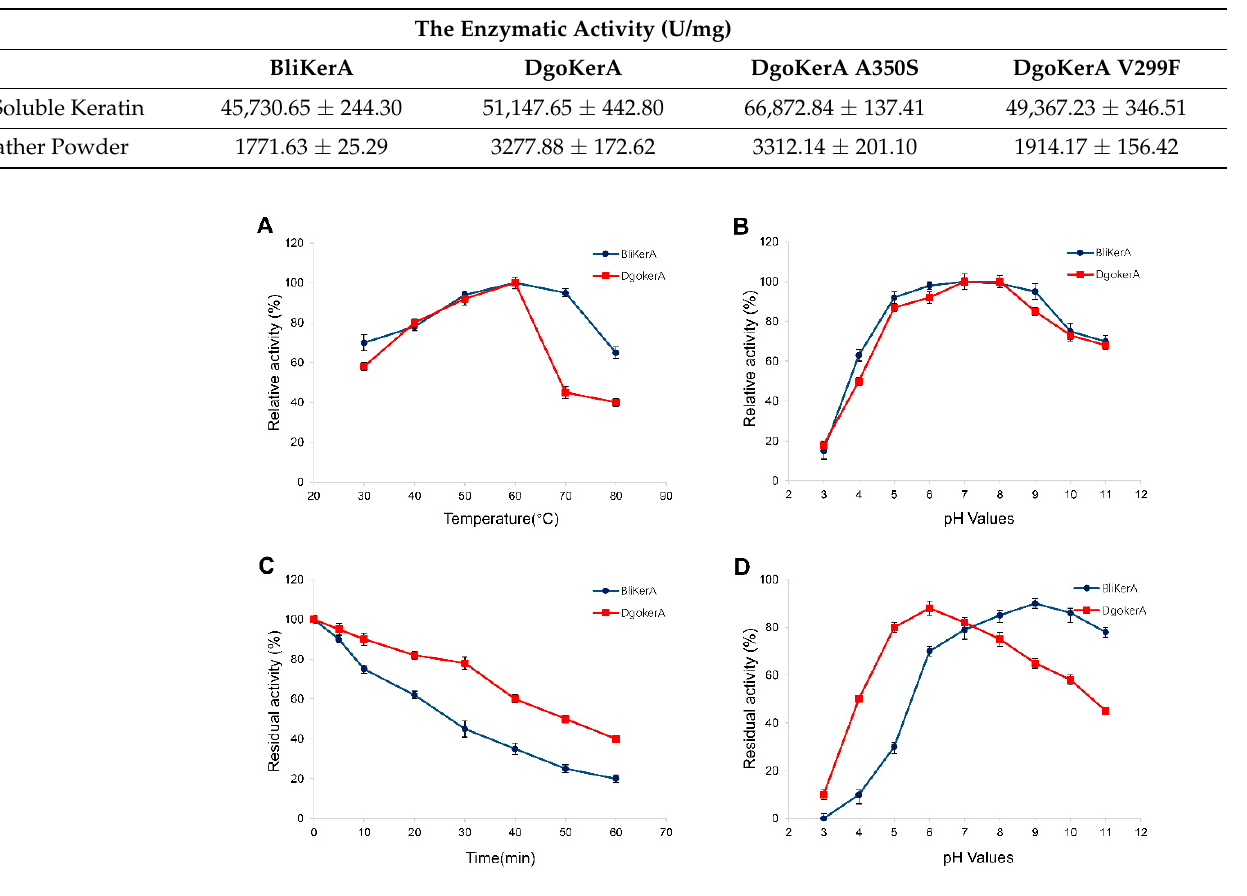
Figure 4. Effects of temperature and pH on keratinase activity. ( A ) effects of temperature for DgoKerA and BliKerA; ( B ) effects of pH for DgoKerA and BliKerA; ( C ) the thermostability of keratinase; ( D ) the pH stability of keratinase.